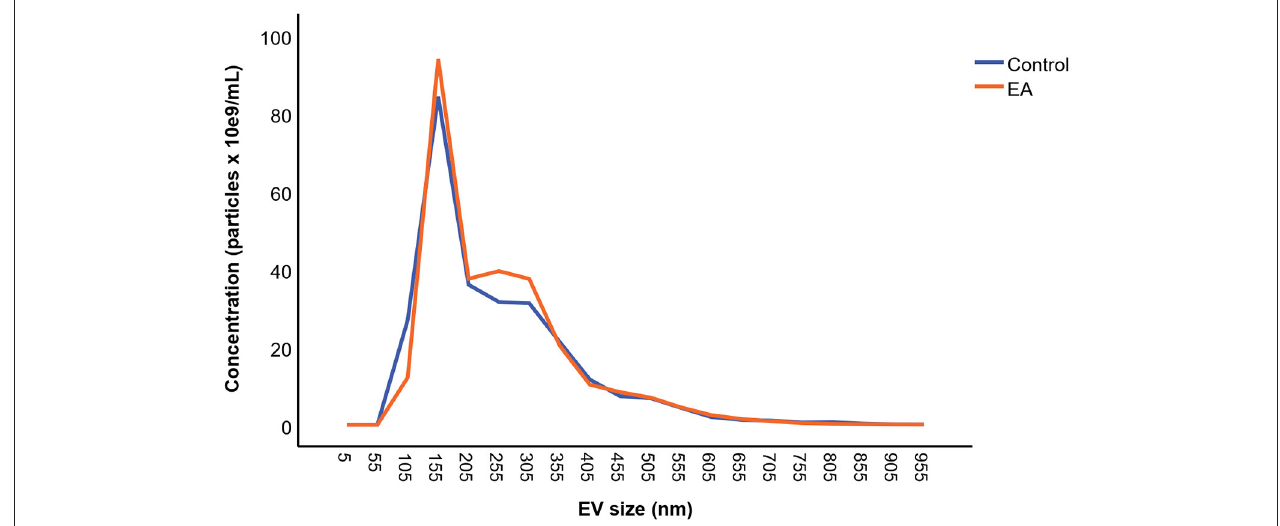
FIGURE 6 | Mean particle concentration and extracellular vesicle (EV) size distribution for the asthmatic (EA) ( n = 35) and control horses ( n = 19). The samples were analyzed by nanoparticle tracking analysis. There was no significant difference between the